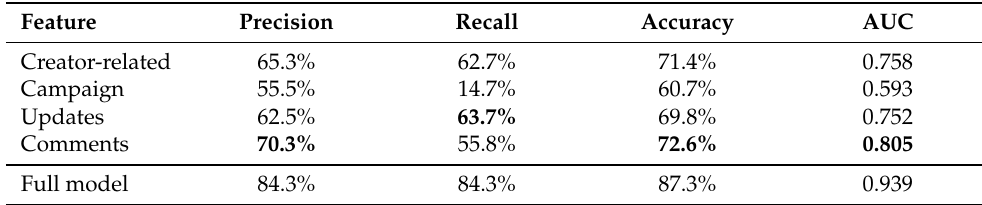
Table 3. Performance of our model built with each category of features using Logistic Regression (Precision and Recall on